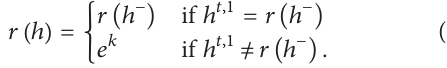
Table 2: Herrero’s startegy. State 𝑒 𝑗 Proposal 𝑒 𝑗 Player 𝑖 Reply 𝑝 𝑖 ≥ 𝛿𝑒